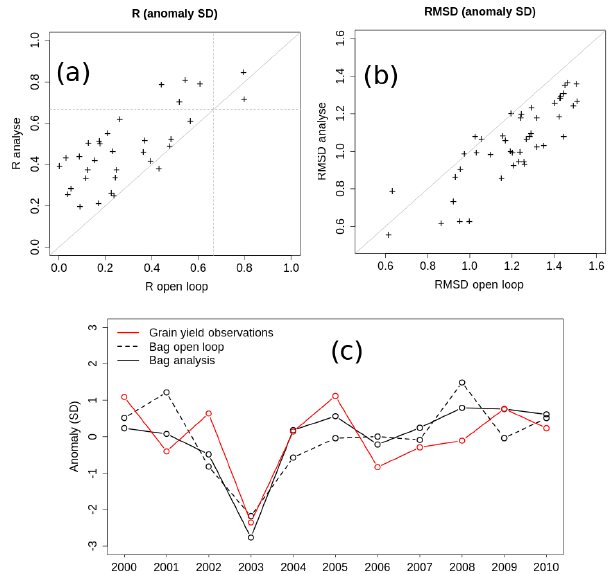
Figure 10. (a) Correlation values for the above-ground biomass from the open loop with grain yield estimates from Agreste French agricultural statistics portal (http://agreste.agriculture.gouv.fr) over 45 sites in France, plotted against correlations between the same quantities but above-ground biomass from the analysis; (b) same as (a) for RMSD values; (c) scaled anomaly time series of above- ground biomass from the open loop (black dashed line), analysis (black solid line) and grain yield observations (red solid) for one site in Allier, France (46.09 ◦ N, 3.21 ◦